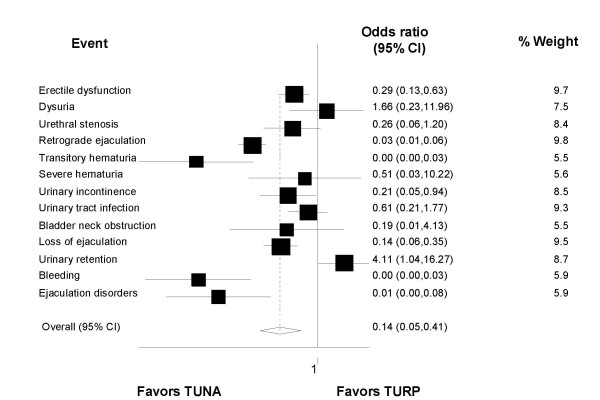
Studies that compare TUNA and TURP. Adverse effects. Results of meta-analysis. Random effects model.  CI denotes confidence interval.